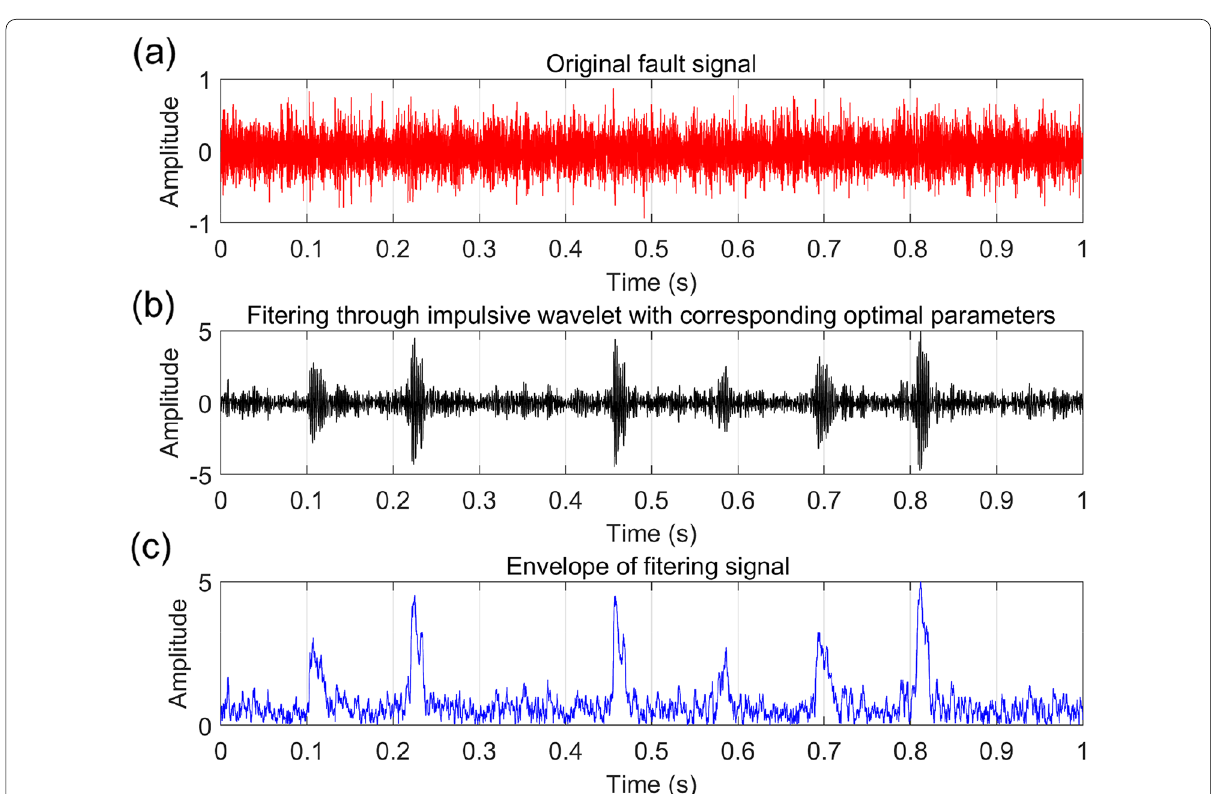
From Figure 23(b) and (c), the periodical components